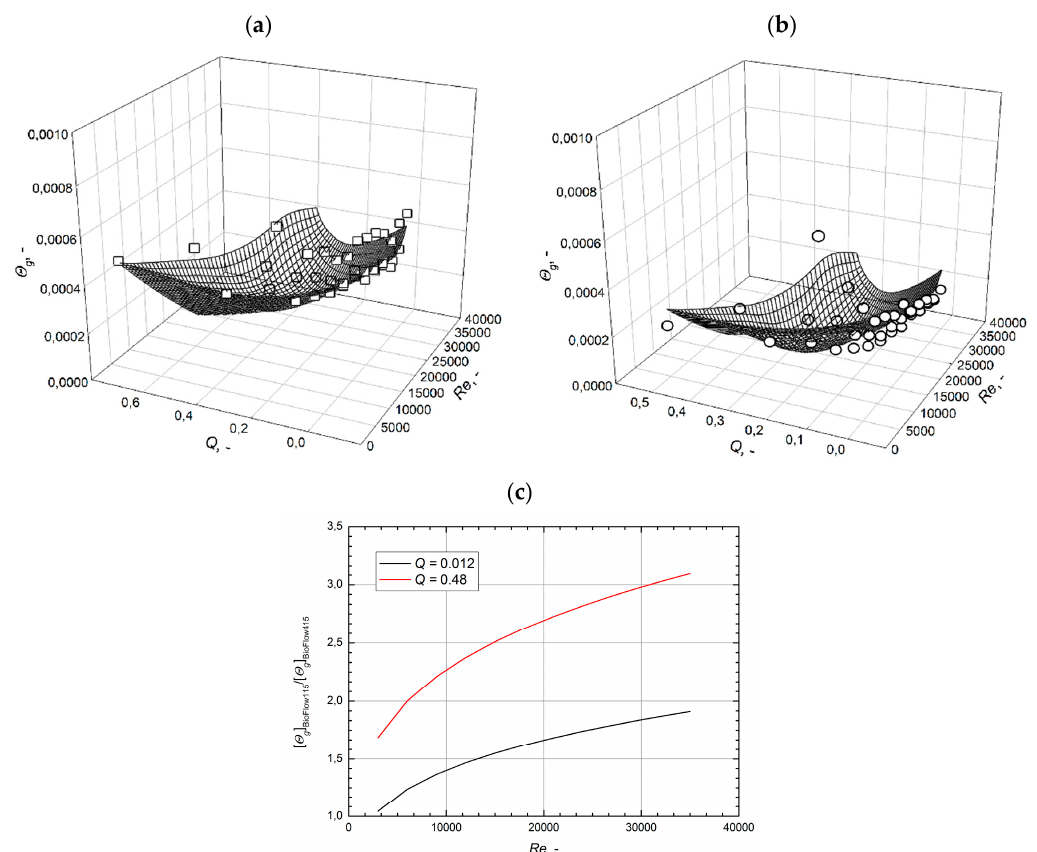
Figure 8. The dimensionless mixing number variation with Reynolds number and flow number for: ( a ) BioFlo ® 115 ( R 2 = 97.28%; S e = 2.99 × 10 − 5 ); ( b ) BioFlo ® 415 ( R 2 = 95.37%; S e = 5.31 × 10 − 5 ); ( c ) comparison of the calculated variation of flow